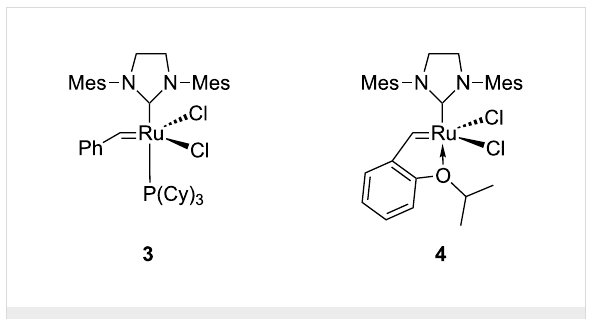
are extended into a thiol-lacking coenzyme A (CoA) derivative by some of the natural CoA biosynthetic enzymes (pantothenate kinase or PanK, phosphopantetheine adenylyltransferase and dephosphocoenzyme A kinase). The resulting inactive CoA analog affects downstream pathways such as the acyl carrier protein activation required for fatty acid biosynthesis [13-16].